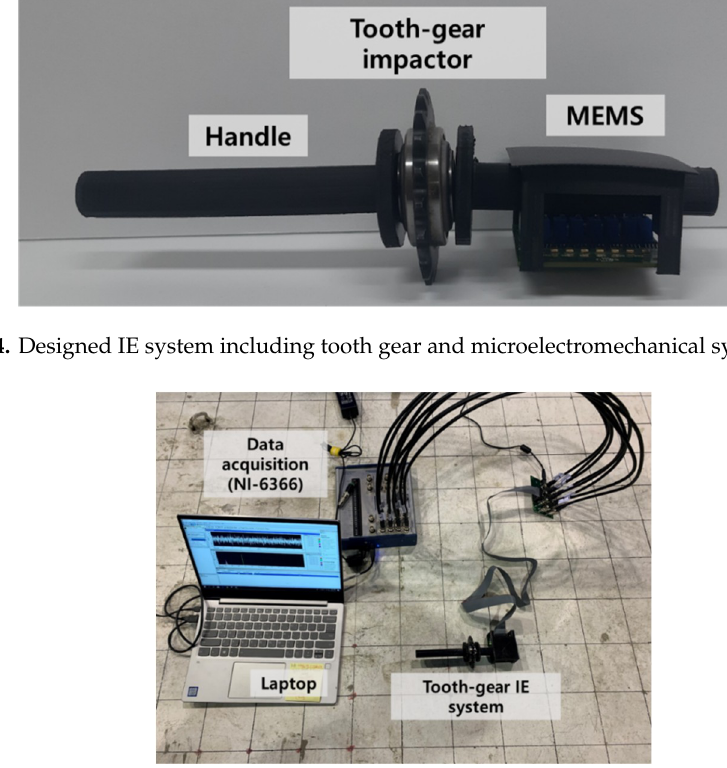
Figure 5. Data acquisition and experimental set-up for the IE system.